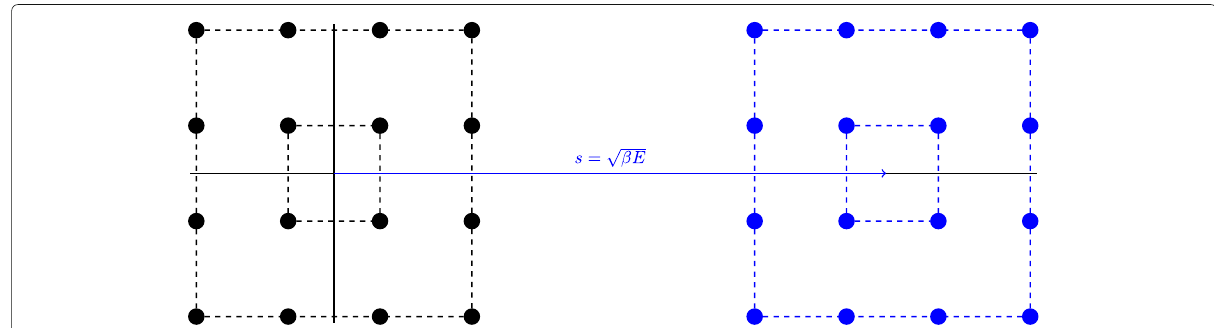
Fig. 2 Effect of the proposed technique on the constellation of 16-QAM. The resulting constellation is shifted along the horizontal axis, i.e., it is asymmetric around the